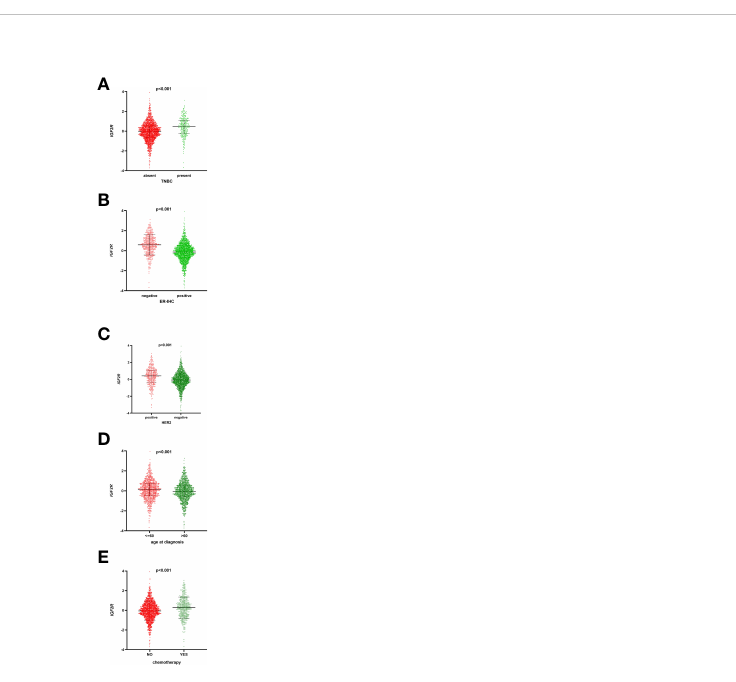
FIGURE 3 IGF2R expression with other clinical characteristics in the METABRIC datasets. (A) IGF2R expression in patients with TNBC and in other patients. (B) IGF2R expression in ER-negative patients and ER-positive patients. (C) IGF2R expression in HER2-positive patients and HER2-negative patients. (D) IGF2R expression in patients aged ≤ 60 years old and in patients aged >60 years old. (E) IGF2R expression in patients with chemotherapy and in patients without